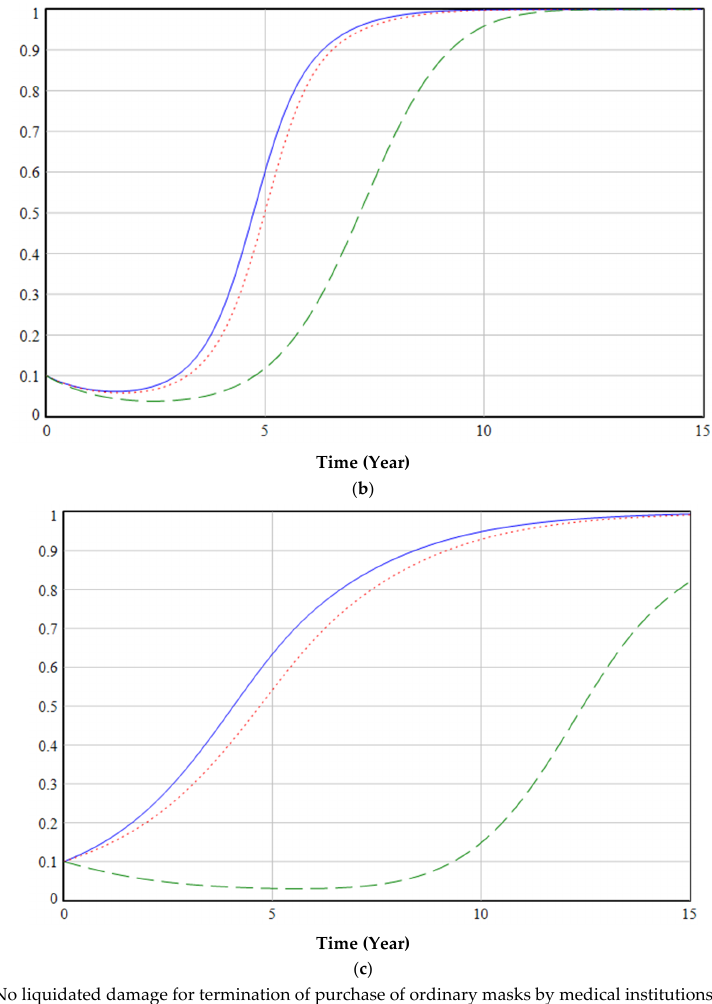
Figure 16. The effect of 2 f on decisions of government ( a ), enterprises ( b ), and medical institutions ( c